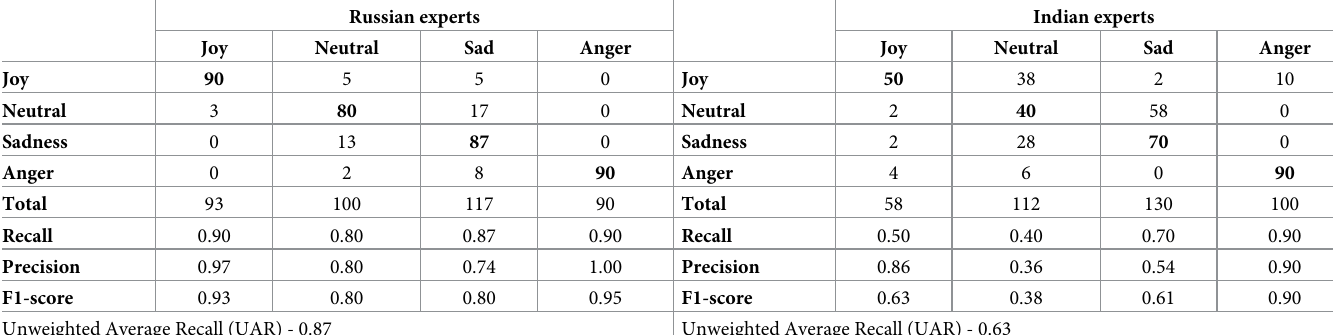
Table 8. Confusion matrix for emotion recognition in the emotional words & phrases of Russian children by Russian and Indian experts. Russian